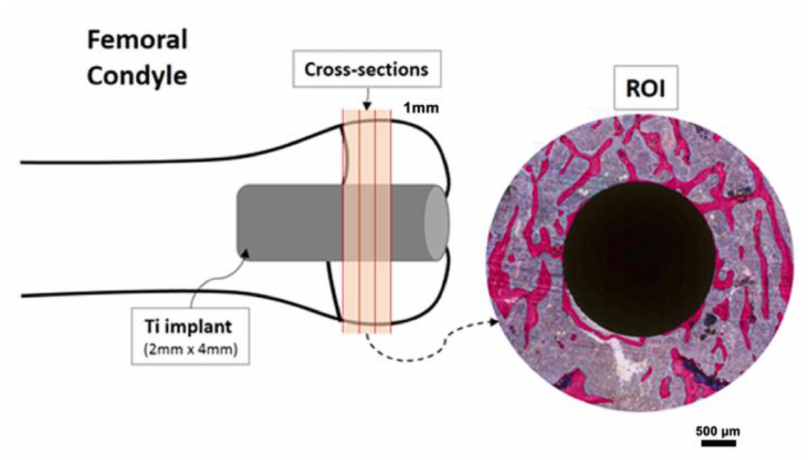
Figure 4. Cross-sectional light microscopical images (left column) show the evident presence of a trabecular bone network around implants in the sham-operated (SHAM) rats. The trabecular network was less dense around the implants in the ovariectomized (OVX) rats. In the identified ROI (right column, magnification 20 × ), more trabecular bone was observed surrounding and in direct contact with implants in the SHAM rats. In OVX rats, the bone around the implant surface is less, thin and